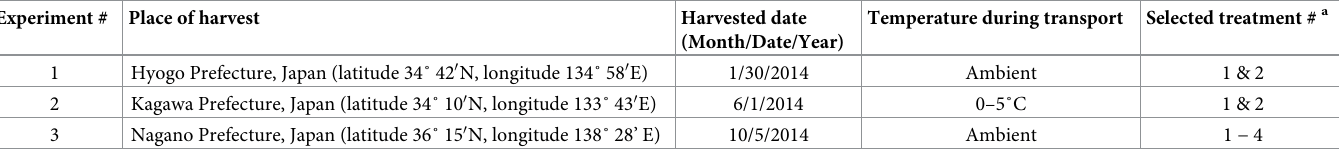
Table 1. Broccoli heads used in the present study.